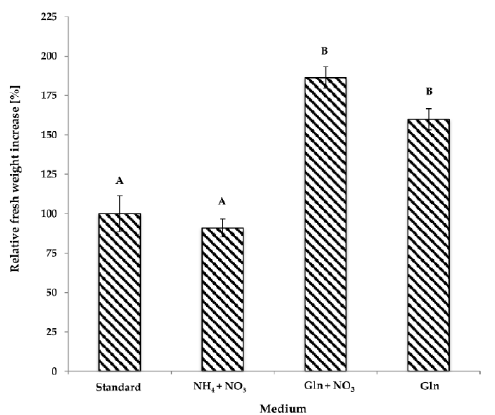
Figure 2. Relative fresh weight increase (%) of PEM cultures after ten days on different proliferation media: standard medium, NH 4 + NO 3 medium, Gln + NO 3 medium and Gln medium. Proliferation rates have been related to the standard medium. Bars indicate standard errors. Different letters above the columns indicate significant differences based on the Tukey-Kramer HSD test, p ≤ 0.05.